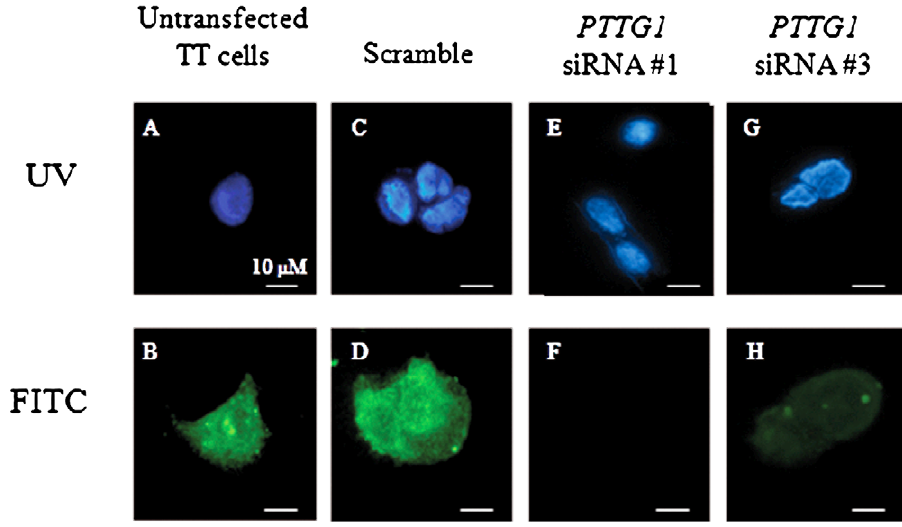
Fig. 4. PTTG1 protein expression. TT cells were transfected with scramble siRNA, or with PTTG1 siRNA #1 and #3 and fixed 48 h after transfection. Untransfected and transfected TT cells were incubated with the specific PTTG1 antibody, fixed, incubated with the secondary FITC-conjugated antibody, mounted with the antifade reagent containing DAPI, and photographed with a 60 × objective magnification. Cells were observed with the FITC filter, revealing specific PTTG1 immunofluorescence, and with the UV filter, revealing nuclear fluorescence. Figures are representative of at least three